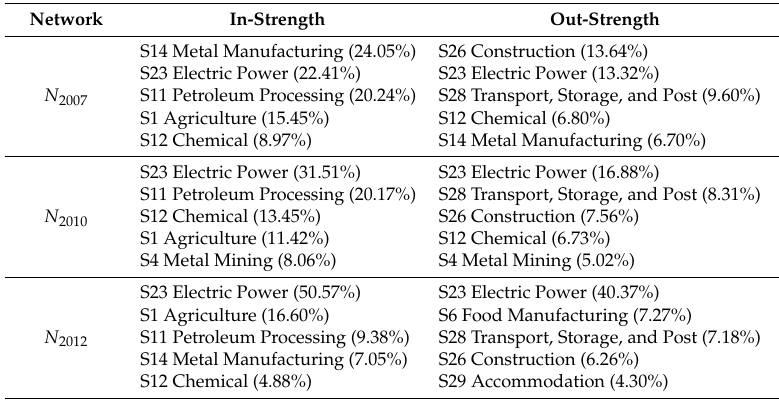
Figure 8. Top 20 sectors in each network in terms of strength. The order of the networks from left to right is the in-strength of 2007, 2010, and 2012, and the out-strength of 2007, 2010, and 2012, respectively. Table 4. Top five sectors in each network in terms of strength.